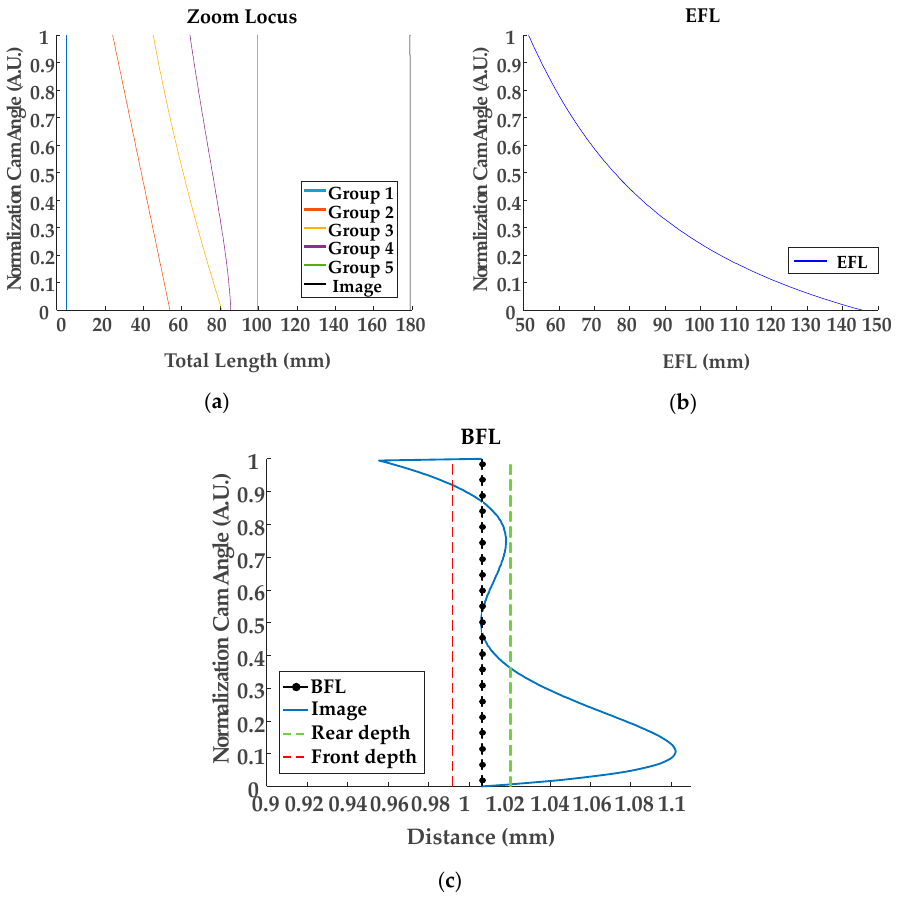
Figure 11. Linearization of the second lens group using the Padé approximation, as shown in Table 10. ( a ) Zoom locus of each lens group, ( b ) EFL of this optical system, and ( c ) error for image plane (BFL).